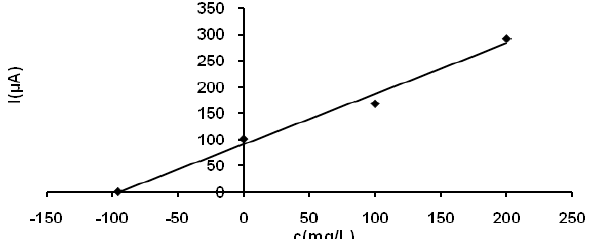
Figure 10: The application of the standard addition method in vinegar. The obtained concentration, 95.1 mg L -1 as sodium sulfite is in accordance with the one obtained by direct voltammetry, illustrating accuracy.